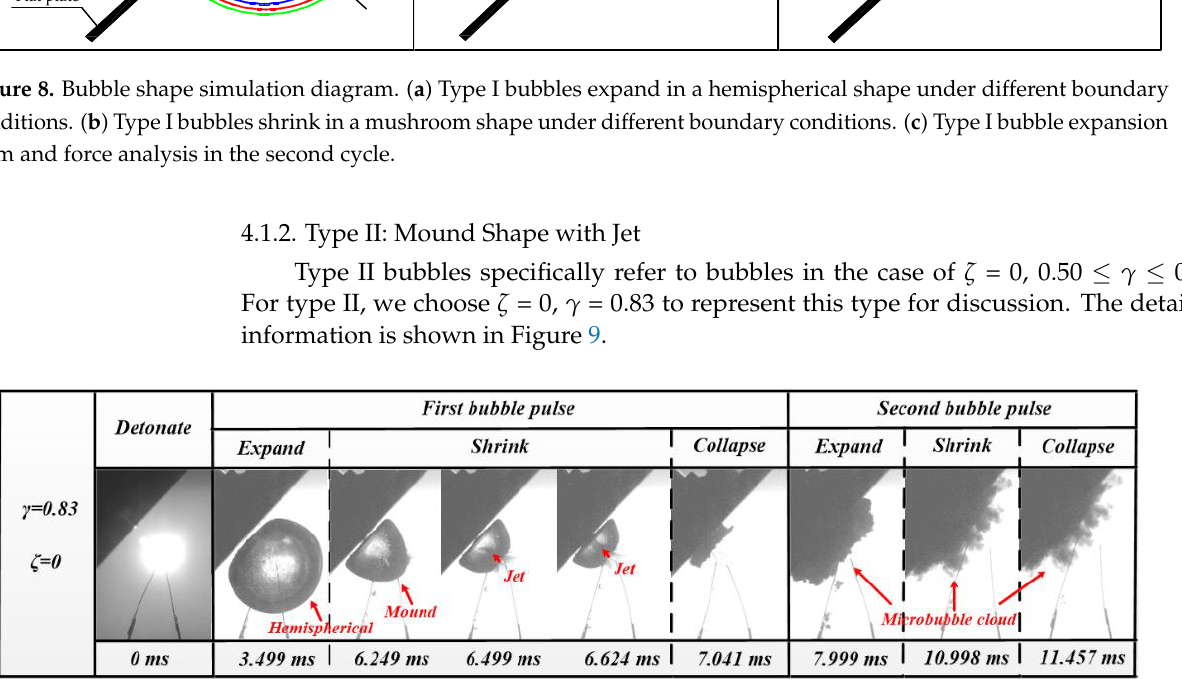
Figure 9. Type II bubble pulsation process diagram. The bubble pulsation process when ζ = 0 and γ = 0.83.